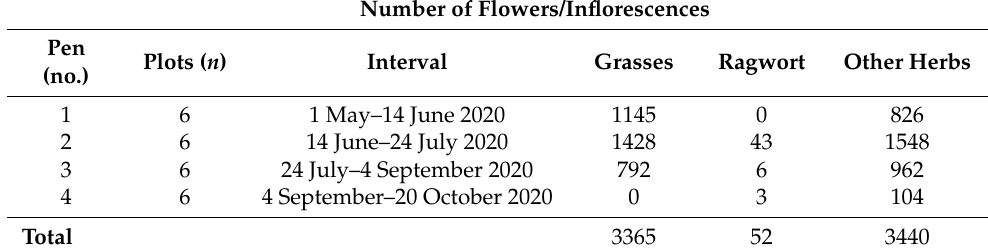
Table 6. Number of flowers of ragwort, other herbs, and grasses counted in botanical plots in both years. n.s. = not